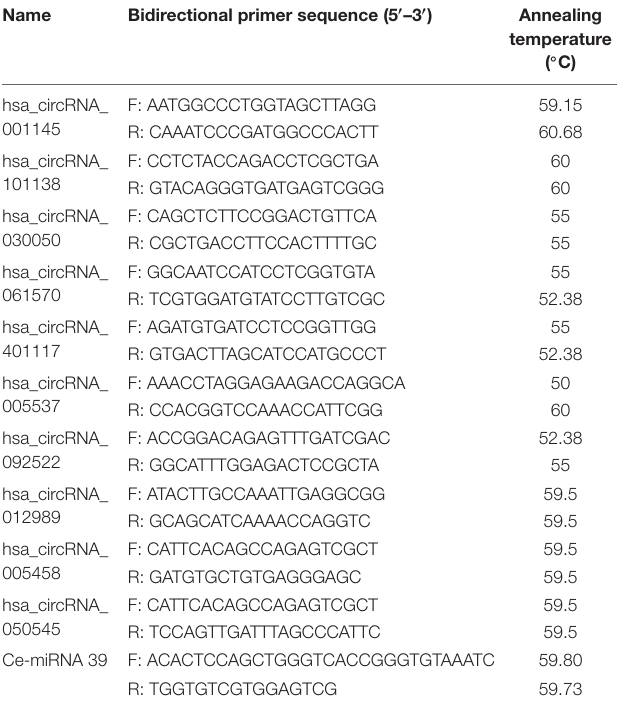
TABLE 1 | Sequences for the primers used for the